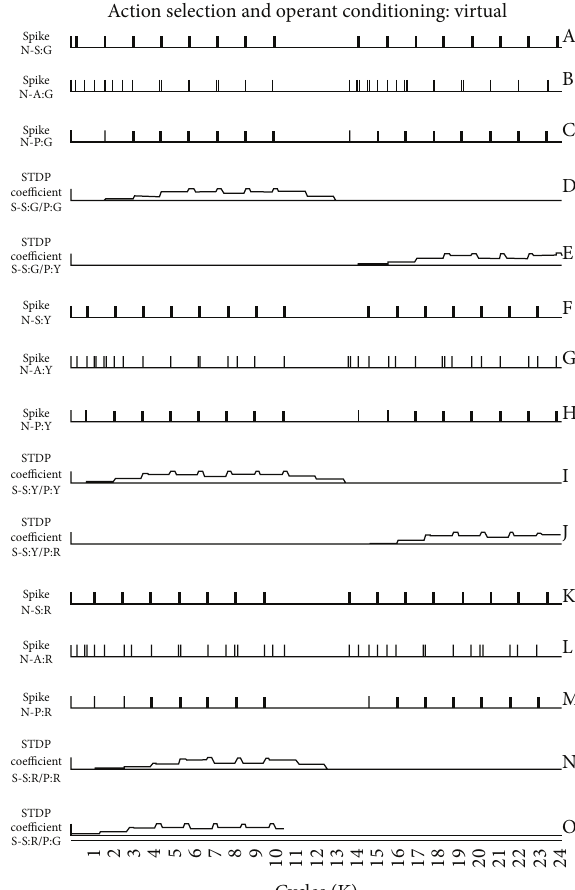
Figure 7: Graphics of the neural spikes and the STDP rule factors occurring over 24000 cycles. The first five (graphics A to E) concern the green block and green LED. The middle five capture the logic of the yellow block and the yellow LED. The last group of five is associated with the red color. Around cycle 8500, the robot has learned to perform the right action with the appropriate cue. This means that, upon triggering an action, if the predictor spikes from a following reward, the STDP coefficient will increase, boosting the synaptic weight between the sensor and the predictor. Once this synaptic weight reaches a critical threshold, the sensor input will trigger a spike to the reinforced predictor neuron, without the need of the reward.